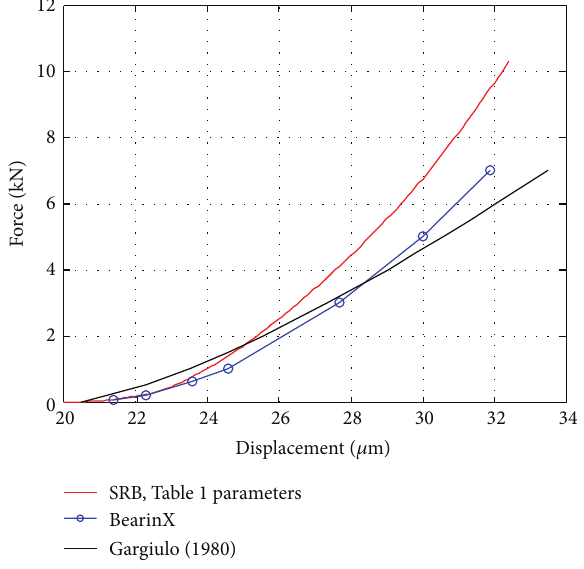
Figure 8: Effect of clearance on elastic deformation of the bearing. In this case, the elastic deformation is calculated by 𝑒 𝑦 − (𝑐 𝑑 /2)